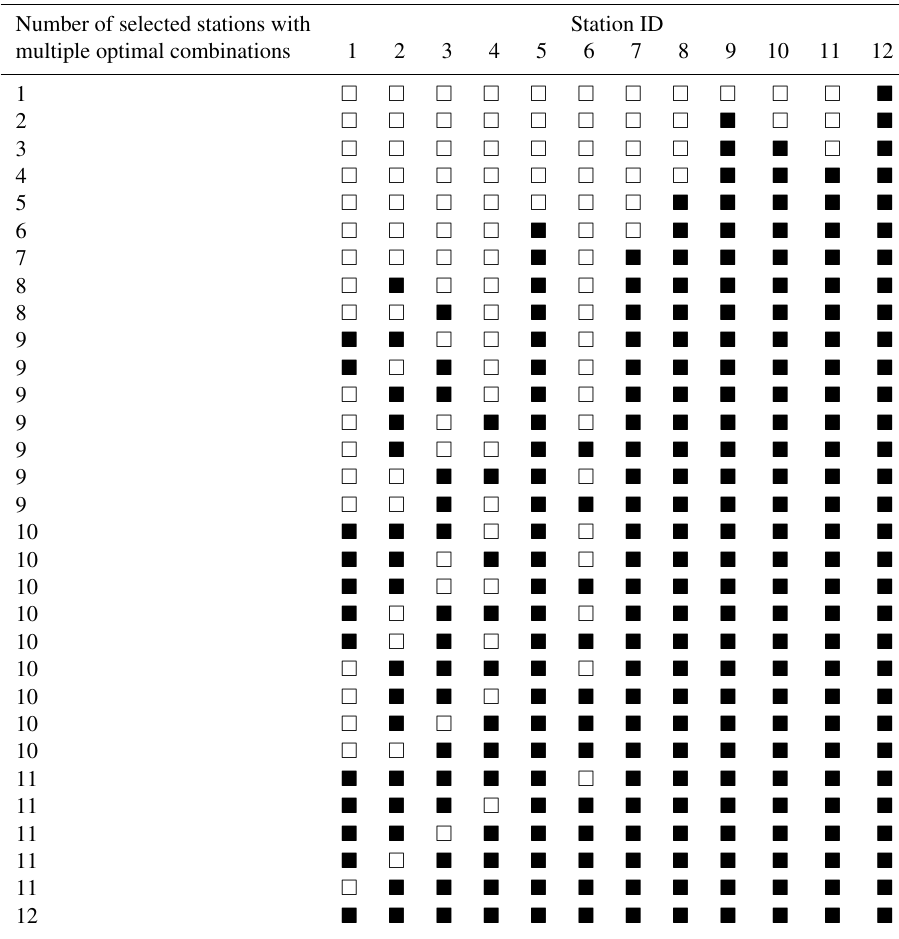
Table 4. All optimal combinations of sensors for the joint entropy objective. For number of sensors above 7, multiple optimal combinations can be found due to saturation of joint entropy. Black squares are selected sensors. Number of selected stations with